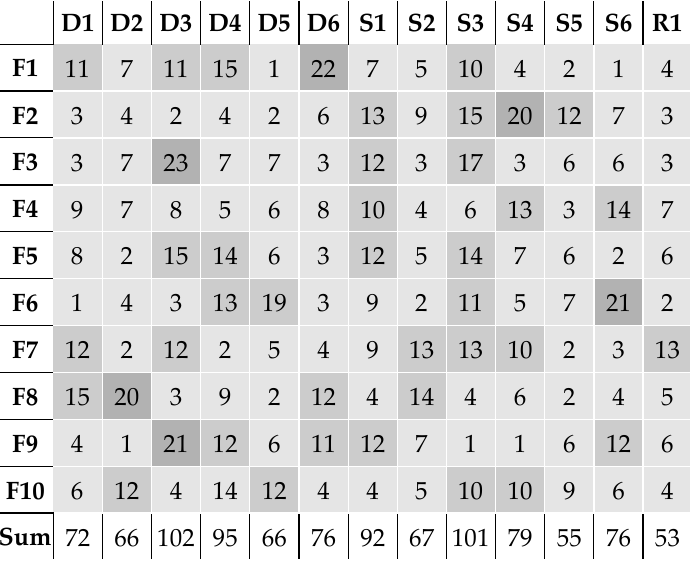
Figure 4. Attribute weight matrix of function replacement multi-objective attribute decision-making model.